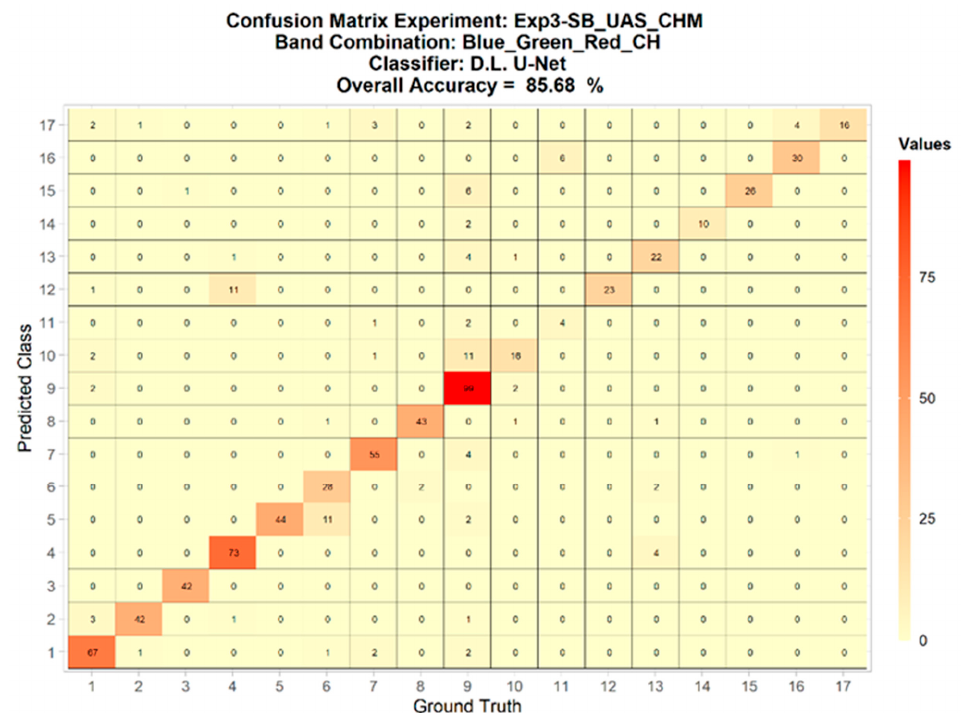
Figure A20. Confusion matrix for the best results obtained in Exp3-SB_ UAS_CHM, using the DeepLabV3 architecture (the Blue_Green_Red_RE_CH band combination).